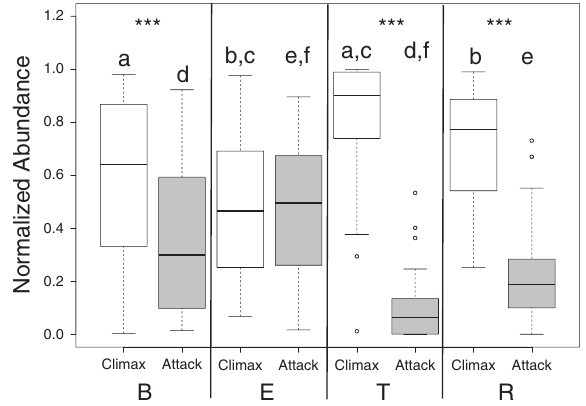
Fig. 4 Boxplot distributions of Climax and Attack communities according to assignment of OTU membership from the 16S rRNA gene network topology (see methods). Statistical signi fi cance is tested within clinical state using the Student ’ s t -test (Bonferroni corrected p -value = p < 0.0125, *** = p < 0.001) and across clinical states with the Tukey ’ s test of a one-way ANOVA. Letters designate statistical signi fi cances where a shared letter indicates two distributions that were signi fi cantly different (a = 0.014, b = 0.04, c = 0.0012, d = 5.7 × 10 − 5 , e = 0.0041, f = 4.5 × 10 − 6